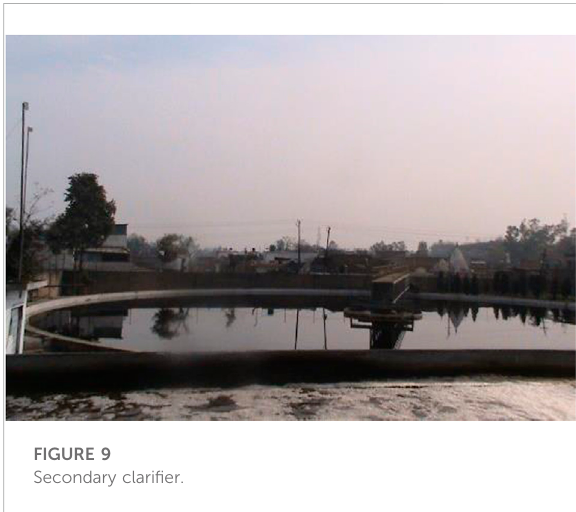
FIGURE 6 Primary clari fi er.